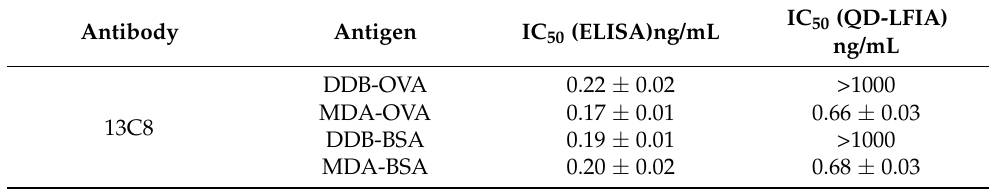
Table 2. The effect of different antibody–antigen pairs on the IC 50 of carbofuran by ELISA and LFIA. Antibody